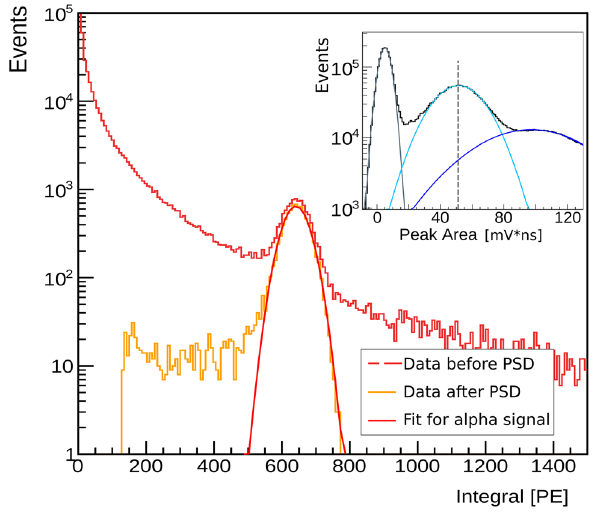
Fig. 10 Integral histogram of a given run of the TTX sample mea- surement before and after the pulse shape discrimination. Inset shows a zoom in the SPE peak region, which is used for the PE calibration